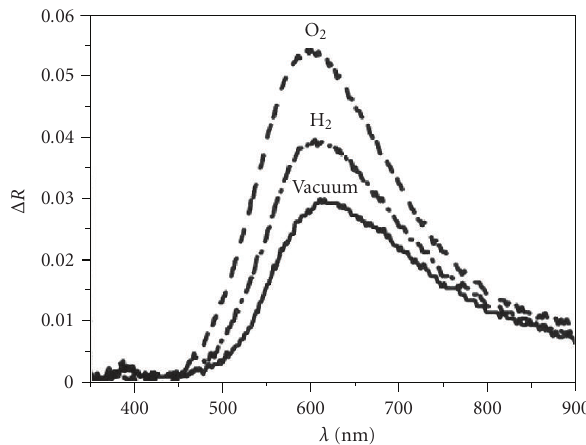
Figure 17: Kinetics of photobleaching (recorded at λ = 595 nm) of photoinduced color centers on irradiation of TiO 2- x N x at λ > 610 nm in vacuum, in the presence of oxygen and in the presence of hydrogen. Reproduced with permission from [71].